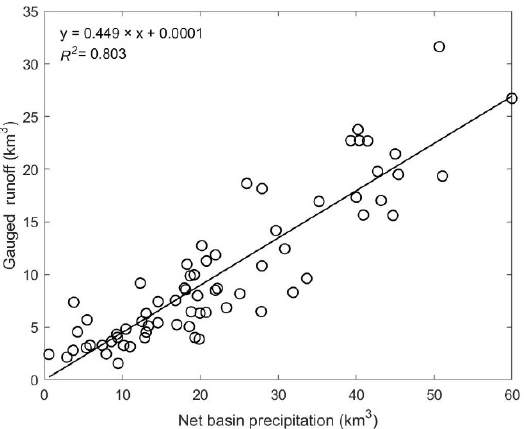
Figure 4. The relationship between the total discharge of the five rivers and net basin precipitation during 2001–2006.